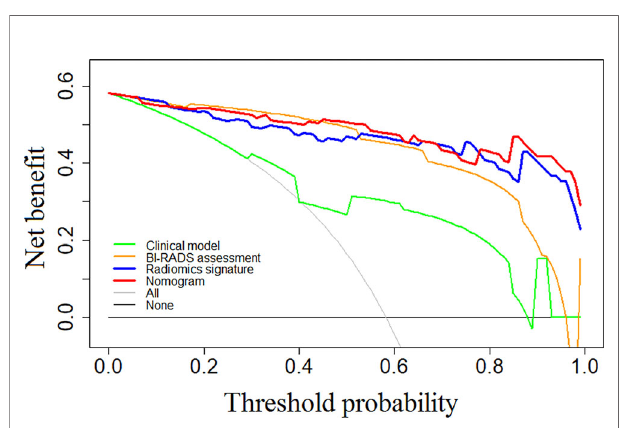
FIGURE 3 | Showed results of the decision curve analysis for each model. The nomogram exhibited greater net bene fi t compared with the combined Rad score or the clinical model. When the threshold probability of the patient was between 0.44 and 0.68, or over 0.78, greater bene fi t can be obtained by using the nomogram, indicating good potential in clinical